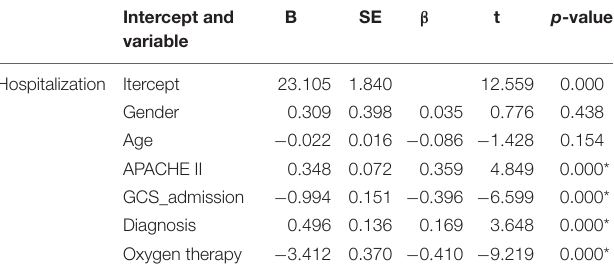
TABLE 9 | Linear regression analysis on length of hospitalization.